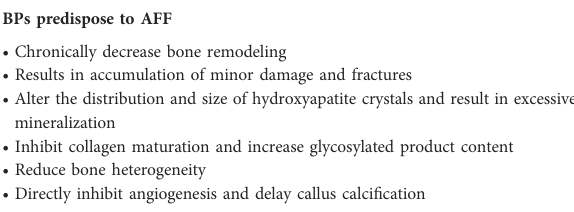
TABLE 1 In fl uences of BPs on AFF and the role of TPTD in AFF management. Atypical Femoral Fractures: Likely Pathogenesis and Therapeutic